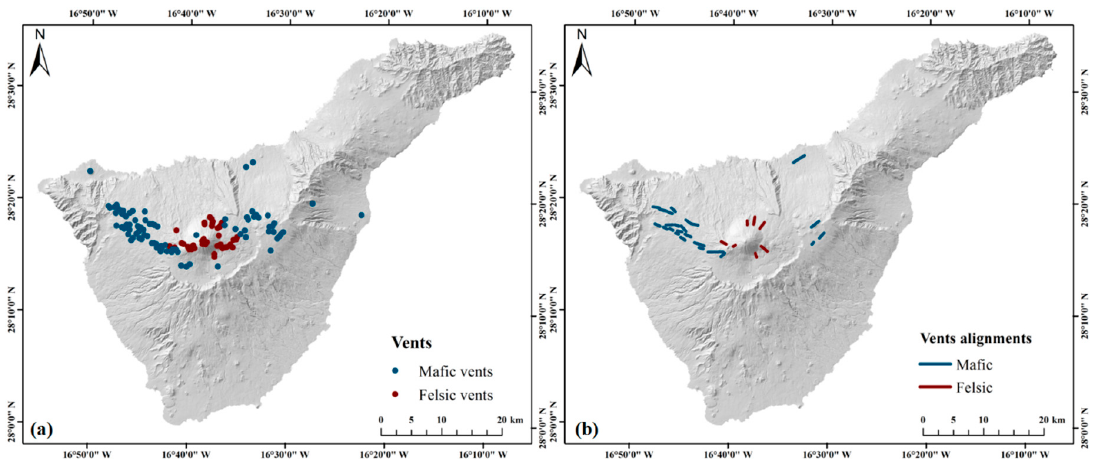
Figure 4. The distribution of vent locations ( a ) and vent alignments ( b ) on Tenerife, extracted from Marti and Felpeto [22] for hazard simulations.